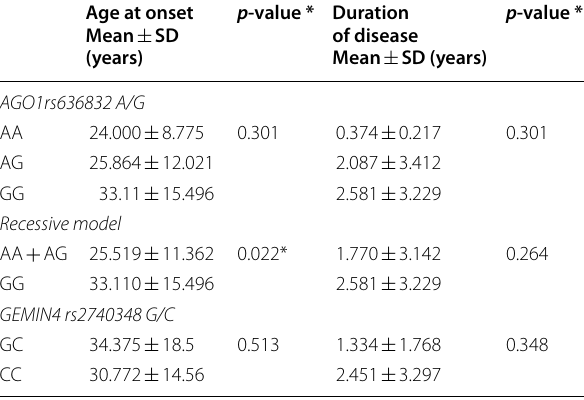
Table 2 Genotypes and age of onset and duration of disease